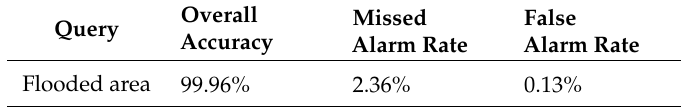
Table 3. Performance evaluation for delimitation of flooded areas in